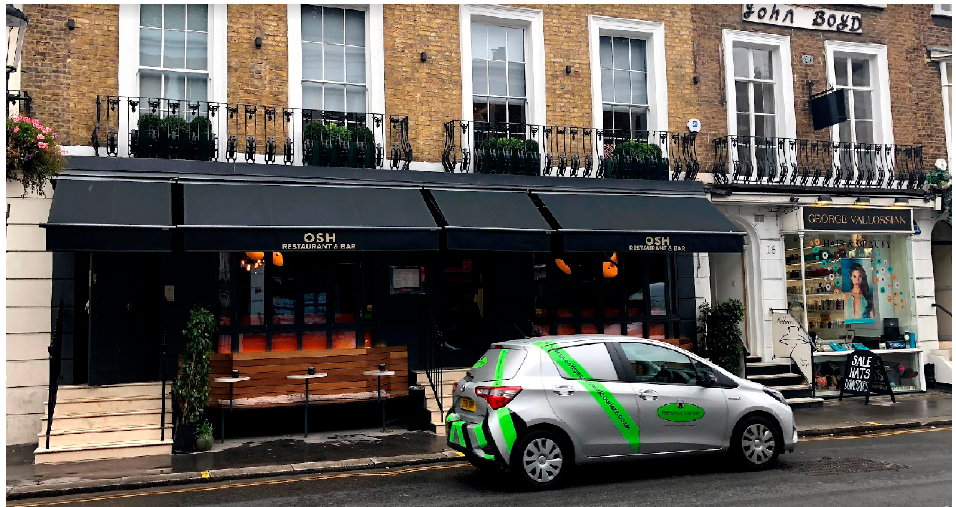
Figure 5. Beauchamp Place—nowadays.